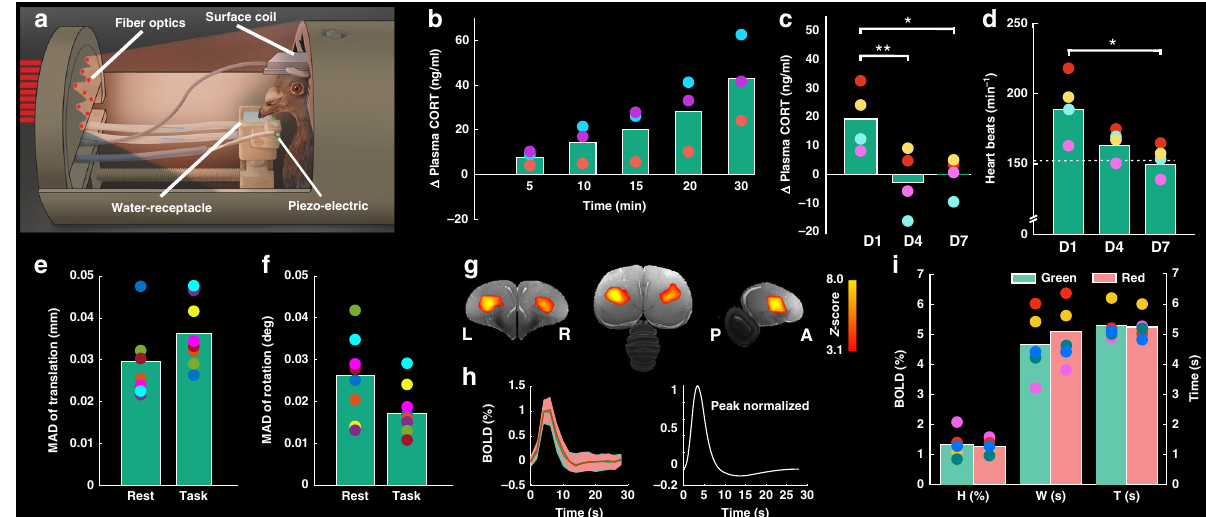
Fig. 1 Platform for awake pigeon fMRI. a Head-restrained pigeons were positioned in the scanner bore center and stimuli were presented using fi ber optics connected to a light stimulator outside the scanner room. Animal responses were registered using a piezo-electric sensor mounted under the lower jaw. b Corticosterone (CORT) increase in response to the adrenocorticotropic hormone (ACTH) stimulation test ( n = 3). Mean CORT concentration increases over time after ACTH administration. c Absolute change in plasma corticosterone on habituation days D1, D4, and D7. Absolute change in CORT was signi fi cantly lower on habituation day 4 and day 7 compared to habituation day 1. Bars = mean values of absolute corticosterone level change ( n = 4). ** p = 0.016, * p = 0.037 (one-way repeated-measure ANOVA, a Sidak correction for multiple comparison). d Heart rate during the habituation procedure on days 1, 4, and 7 ( n = 4). Heart rate was signi fi cantly lower on habituation day 7 compared to habituation day 1 (dotted line = baseline at rest). * p = 0.023 (one-way repeated-measure ANOVA, a Sidak correction for multiple comparison). e , f Median absolute deviation (MAD) of estimated motion parameters (translation and rotation) over resting-state and active decision task ( n = 8). g Example of activation clusters caused by 2 s visual stimulation (calculated for an exemplary pigeon brain for the fi rst run) to estimate the hemodynamic response function parameters. The activation mask from individual pigeons was applied to the other runs to extract the time course of hemodynamic responses within each ROI. h Left curve shows the BOLD signals (HDR) for different visual stimuli. Data are represented as mean ± SEM ( n = 5 animals, number of trials per condition is 300). The right curve shows the best- fi tted pigeon hemodynamic response function ( α 1 = 7.71, α 2 = 11.48, β 1 = 1.74, β 2 = 0.74, c = 0.25). i Estimated parameters of HDR for different colors. Hemodynamic responses did not differ between colors. Each circle in b – f and i represent a single value per individual during different experiments. ACTH adrenocorticotropic hormone, CORT corticosterone, BOLD blood-oxygen-level-dependent, H height, T time-to-peak, W full-width at half-maximum, A anterior, P posterior, L left, R right. Source data are provided as a Source Data fi